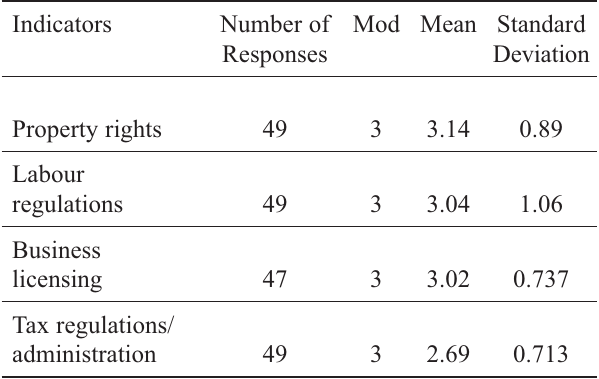
Table 8 . Functioning of Institutions and Public Services